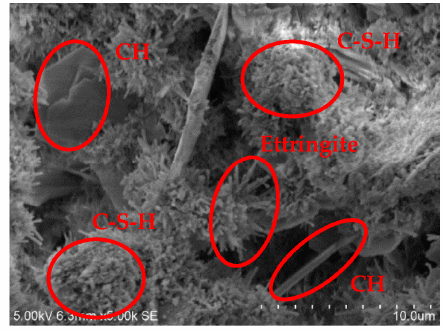
Figure 8. SEM image at 5000× of B24R16 specimen.